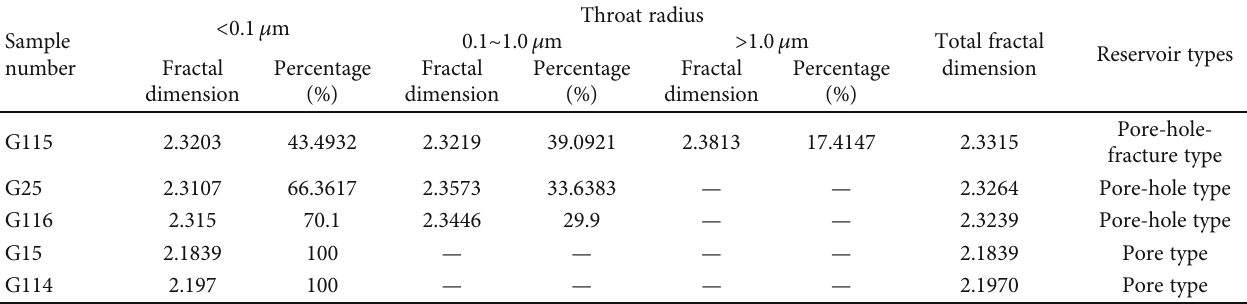
Table 1: Fractal dimensions of pore throat at di ff erent scales in di ff erent tight carbonate reservoirs.